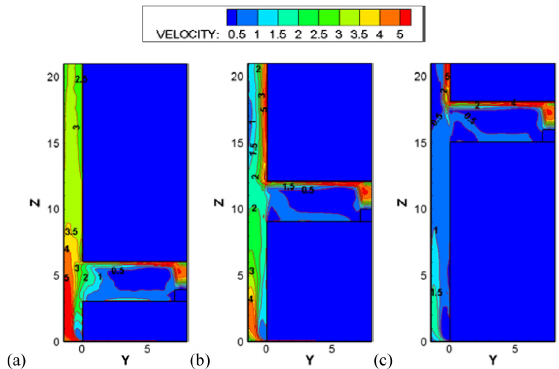
Fig. 8. Velocity distributionat the steady state with Q = 5MW when: (a) Fire on the 2 nd floor; (b) Fire on the 4 th floor; and (c) Fire on the 6 th